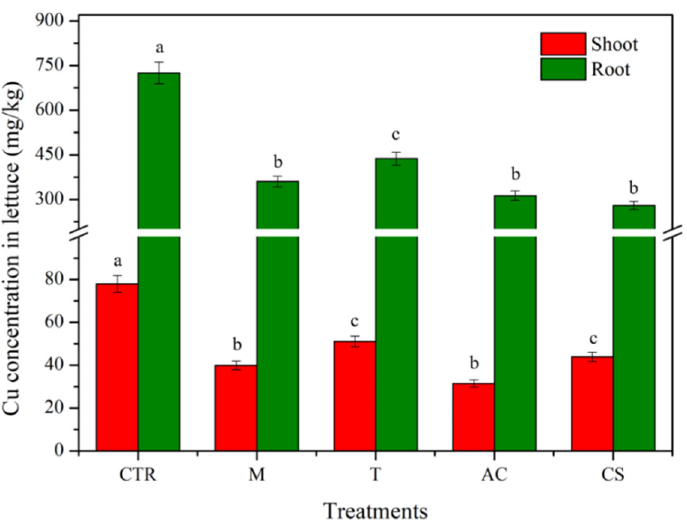
Figure 6. Cu concentration uptake by lettuce in plant uptake test with and without amendments. Means with the same letters are not significantly different from each other under different amendment treatments according to Tukey’s test ( p < 0.05, n = 3) (CTR: control; M: magnetite; T: talc; AC: activated carbon; CS: cornstarch).